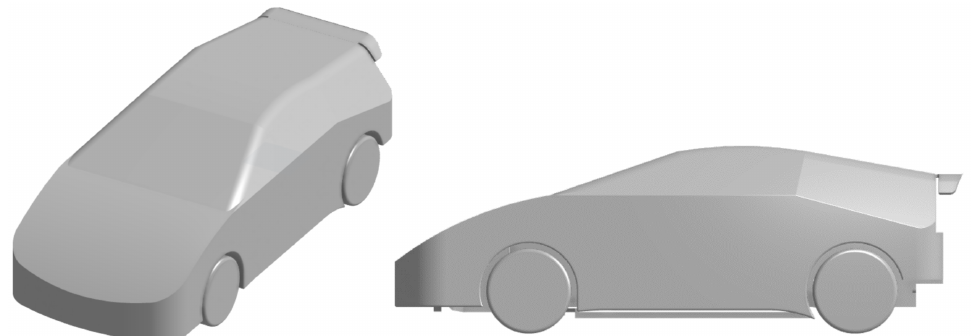
Figure 9. Trimetric and side view of the baseline model (flat underbody).